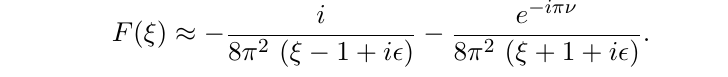
Figure 3 . The timelike geodesics issued from a point Z focus at the antipodal point boundary acts somehow like a (thick) mirror for massive